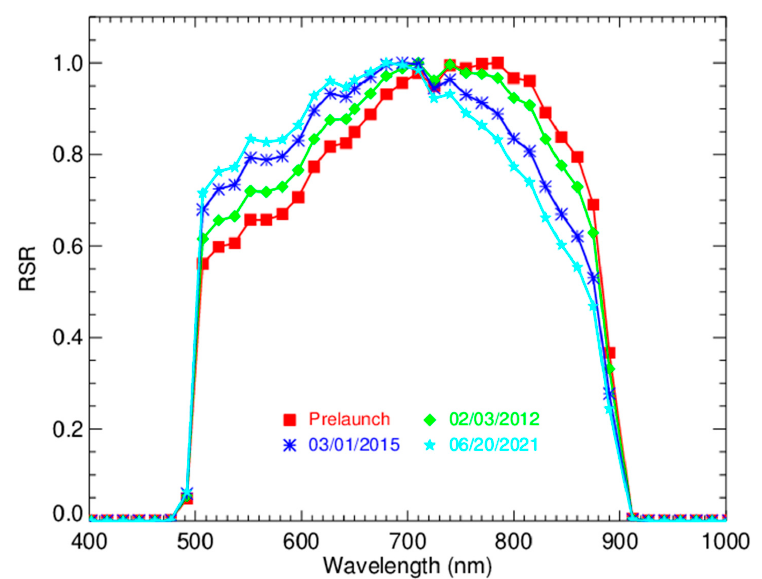
Figure 1. Pre-launch and on-orbit modulated DNB RSR. 3 February 2012, 1 March 2015, and 20 June 2021 present the first, the fifth and the tenth year in operation.